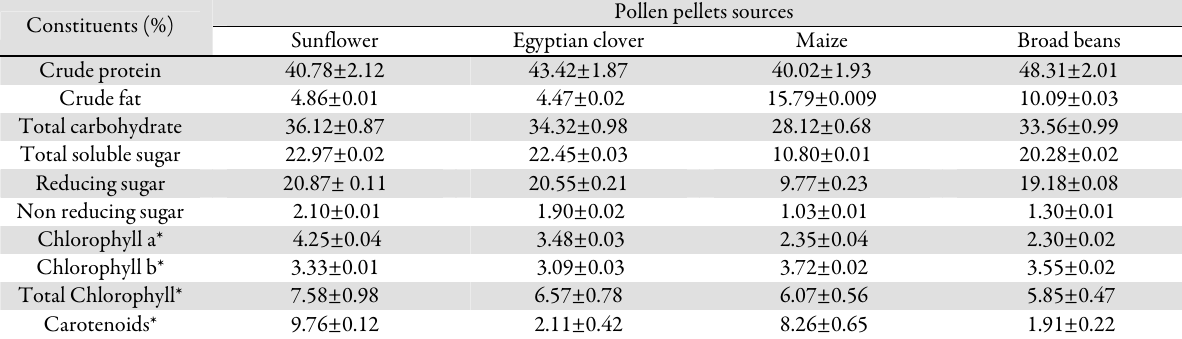
Tab. 1. General analysis of four types of pollen